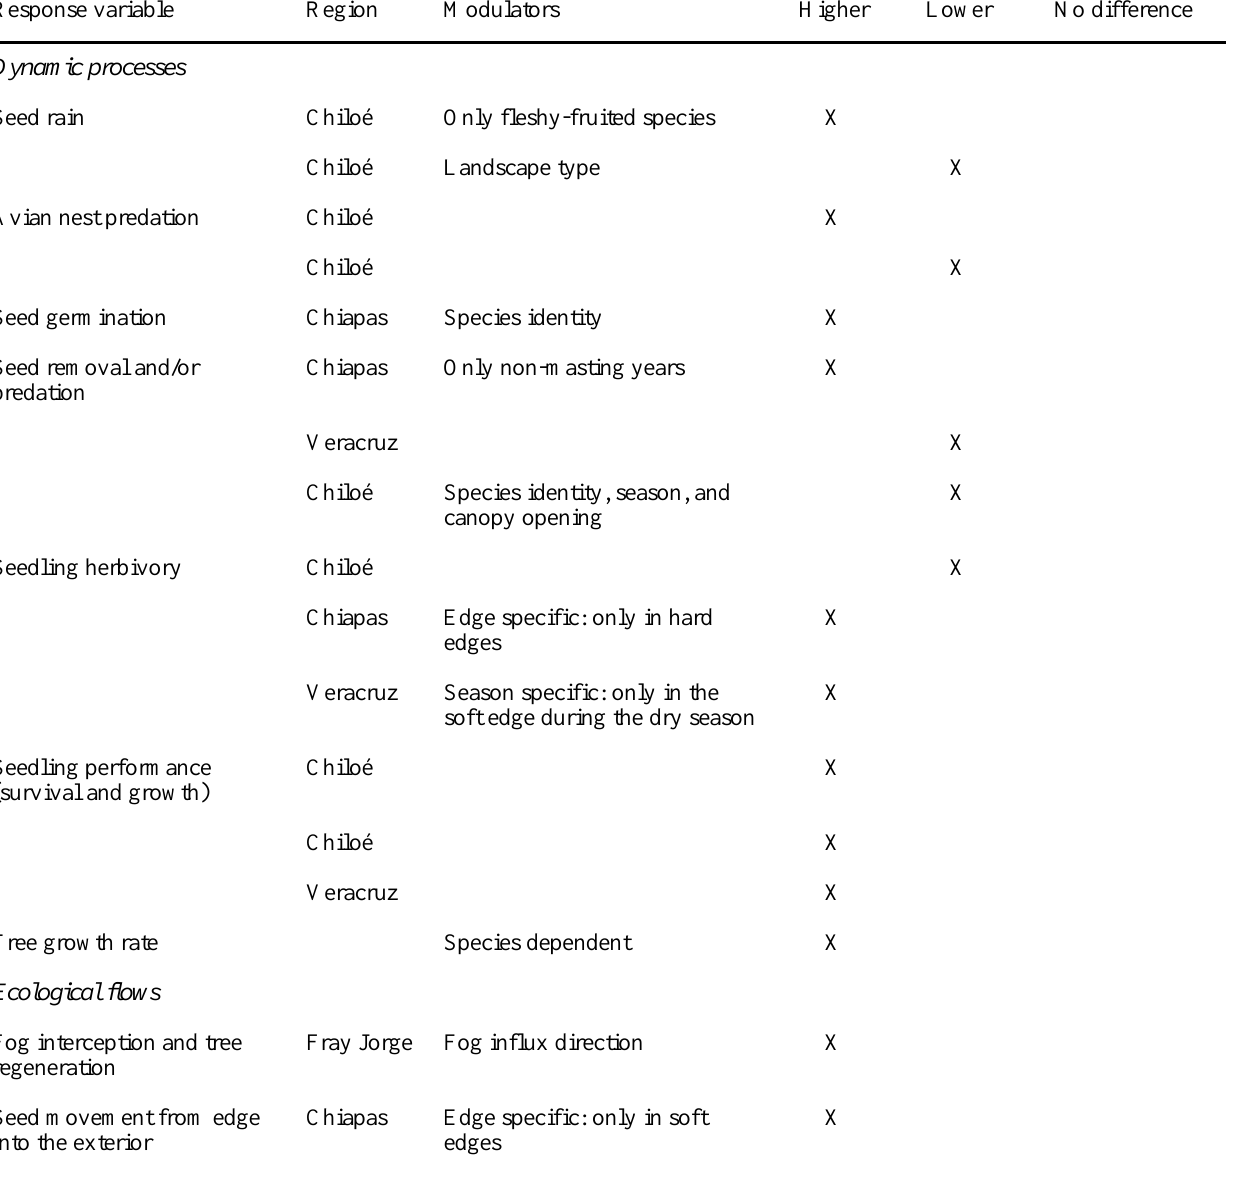
Table 2. Summary of results obtained by investigations assessing edge effects in tropical montane and south temperate rainforests, two forest types that have been almost entirely neglected by previous research (Harper et al. 2005, Ries et al. 2004). Results presented of measurements of ecological processes, patterns, and microclimate at the forest edge (zero meters) compared with the forest interior, showing higher or lower values of the response variable at the edge, or no difference. Modulators are factors that conditioned the observed response. “Hard” and “soft” edges refer to high- and low-contrast edges, respectively (see text). (Adapted from López-Barrera et al.